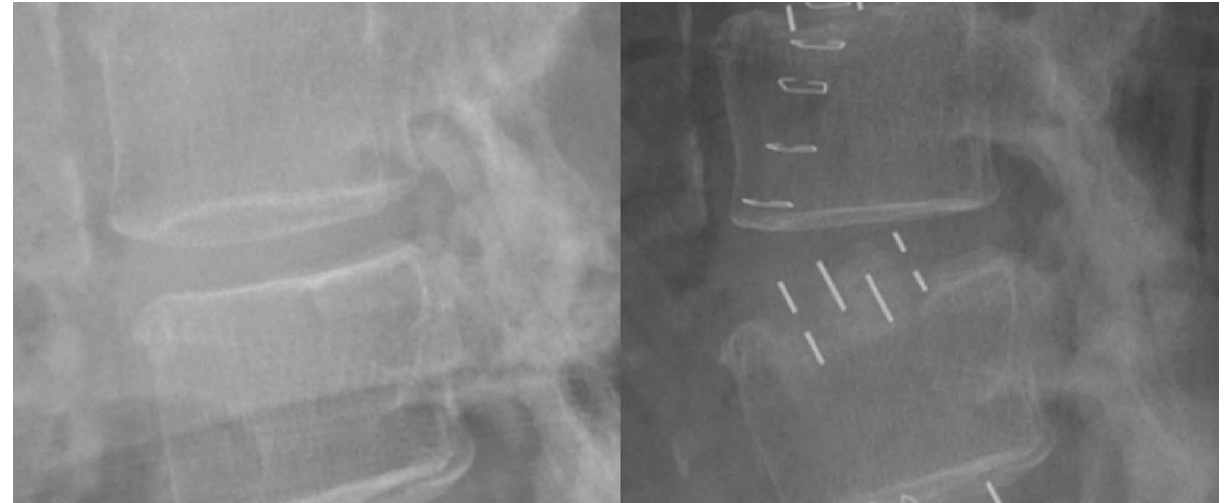
Figure 2. Intraoperative endplate injury during lateral lumbar interbody fusion can be identified by comparison between the preoperative (left) and postoperative (right)